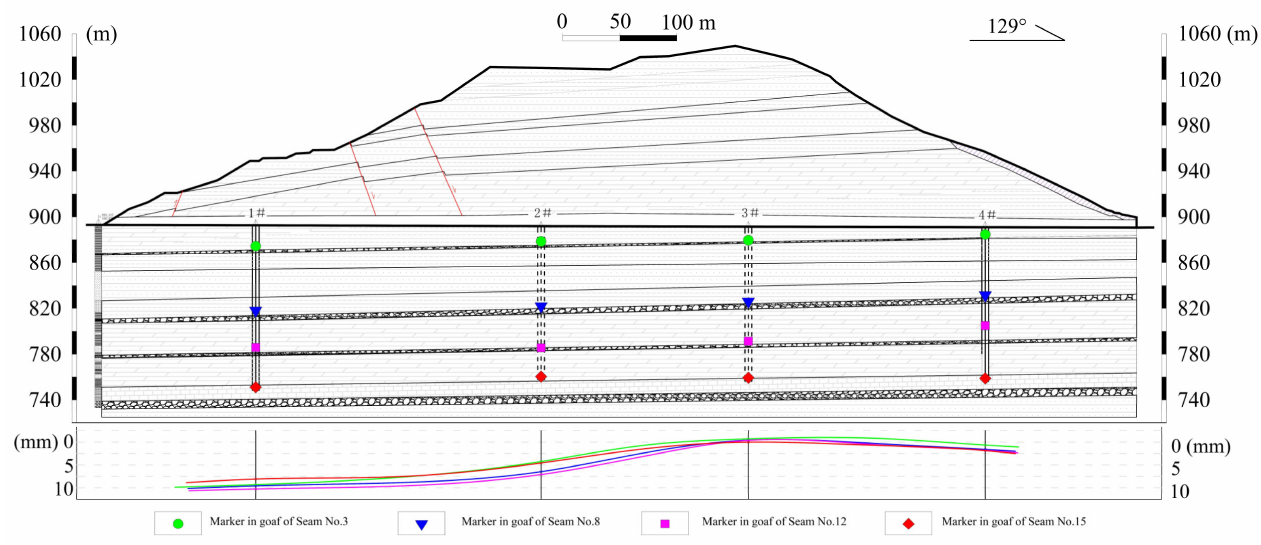
Figure 8. Settlement of bedrock markers in the goaf (maximum slope: 0.05‰).